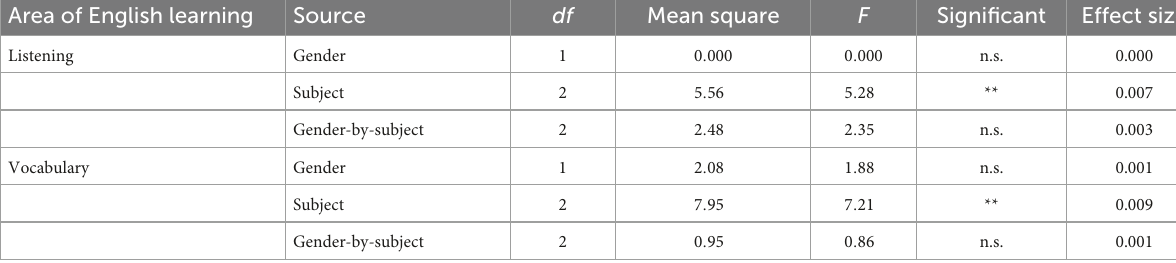
TABLE 2 The gender-by-subject discipline (2 × 3) factorial ANOVAs for English listening and vocabulary. Area of English learning